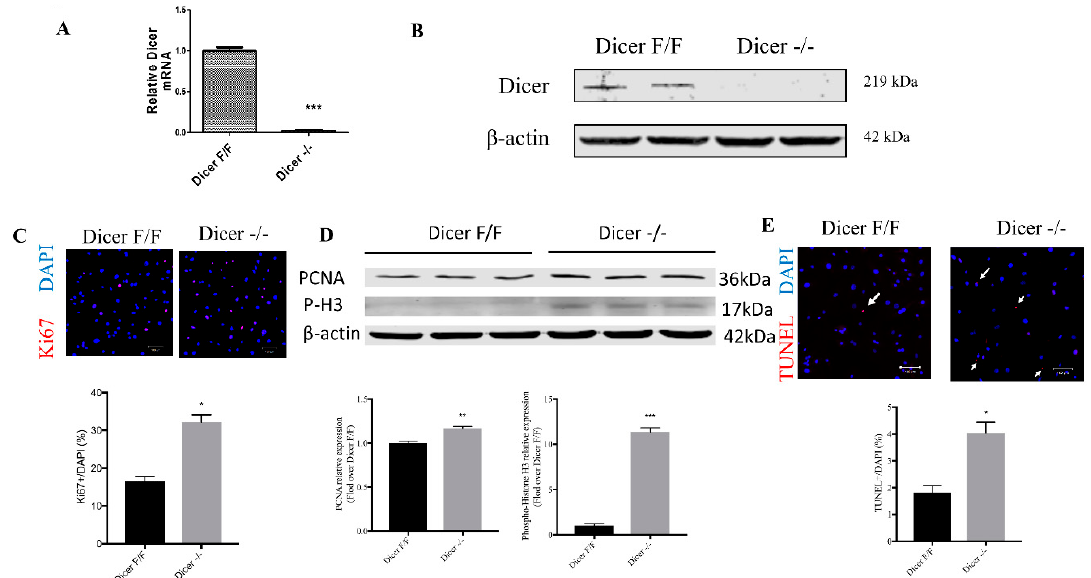
Figure 2. Adenovirus-mediated CRE recombinase expression resulted in a loss of Dicer expression in C-MSC. ( A ) Relative expression of Dicer mRNA. The amount of mRNA was normalized using β -actin. Results are shown as mean with standard error of the mean (SEM) ( n = 3). ( B ) Western blotting of Dicer protein in adenovirus GFP (Ad-GFP) treated Dicer F / F C-MSC (Dicer F / F ), and adenovirus with CRE recombinase (Ad-CRE) treated Dicer F / F C-MSC (Dicer − / − ) using β -actin as a loading control. ( C ) Comparison of the percentage of Ki67-positive cells between Dicer F / F and Dicer − / − C-MSC (scale bar = 100 µ m) (* p < 0.05, n = 6). ( D ) Western blotting of PCNA and Phospho-H3 expression in Dicer F / F C-MSC (Dicer F / F ), and Dicer − / − C-MSC (Dicer − / − ) using β -actin as a loading control (** p < 0.01; *** p < 0.001, n = 3). ( E ) Comparison of the percentage of TUNEL-positive cells between Dicer F / F and Dicer − / − C-MSC (scale bar = 100 um) (*, p < 0.05, n = 20).